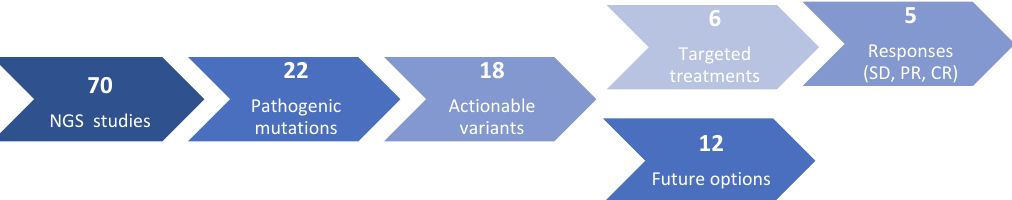
Figure 3. Workflow diagram showing the next-generation sequencing (NGS) process and targeted treatments drawn from the